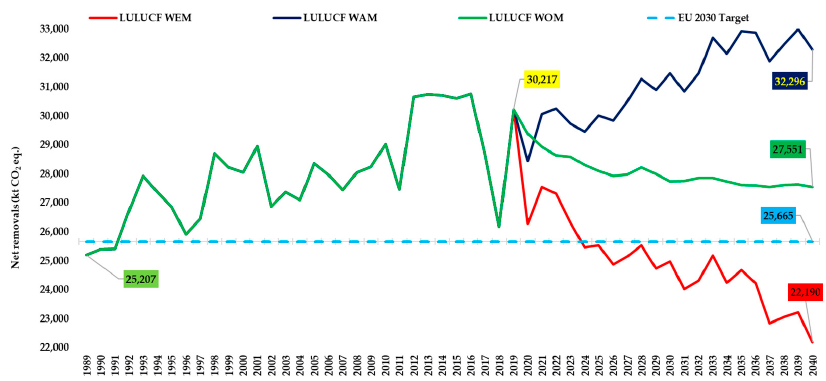
Figure 9. LULUCF GHG emissions/removals scenarios vs. EU 2030 target.